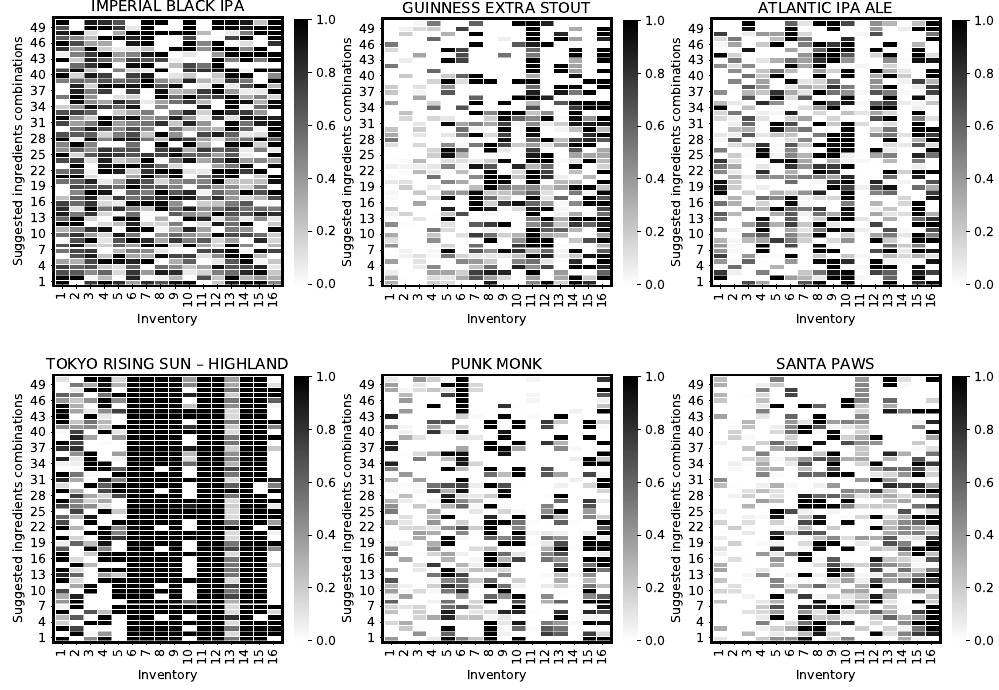
Figure 4. Ingredients combinations generated by the optimising system for the first six products. This illustrates recommended ingredients uptake proportion, as well as independent solutions’ diversity for each of the products. The complete set of ingredients combinations is provided in Appendix A.2 in Figure